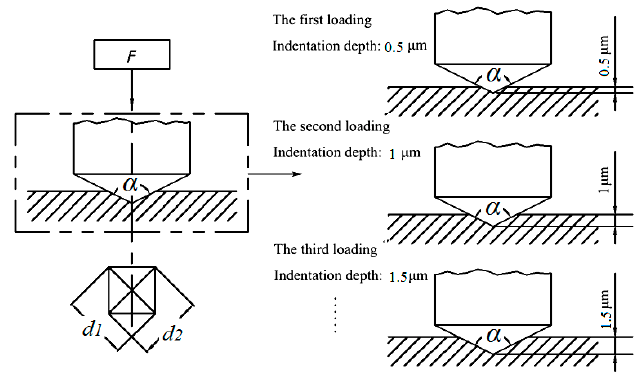
Figure 2. Schematic of the sequential indentation testing procedure and infeed depth interval is 0.5 μ m.